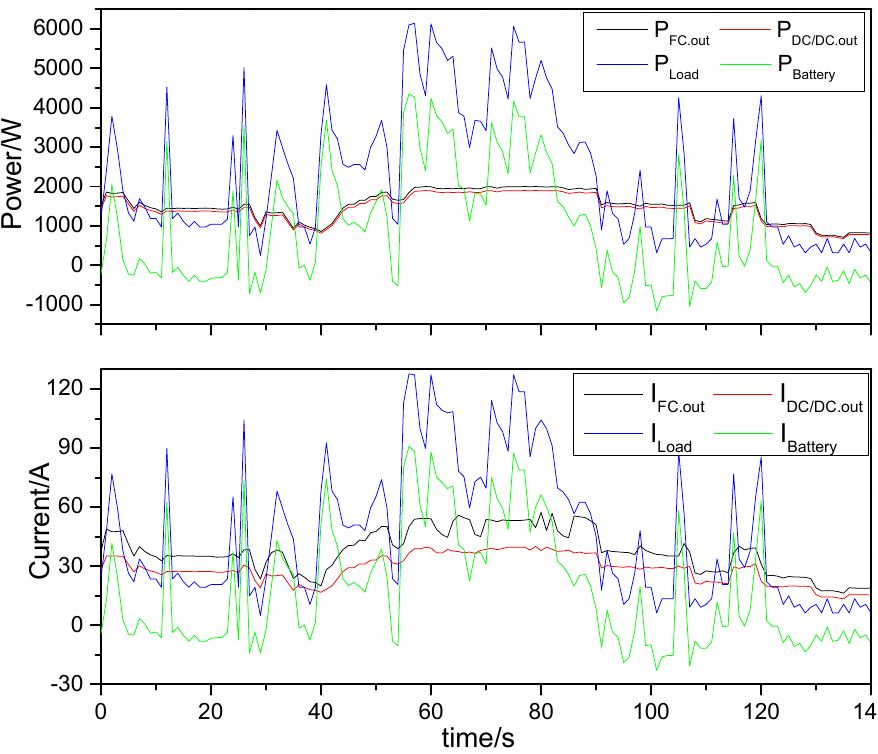
Figure 16. Response curve of moving the hybrid forklift.